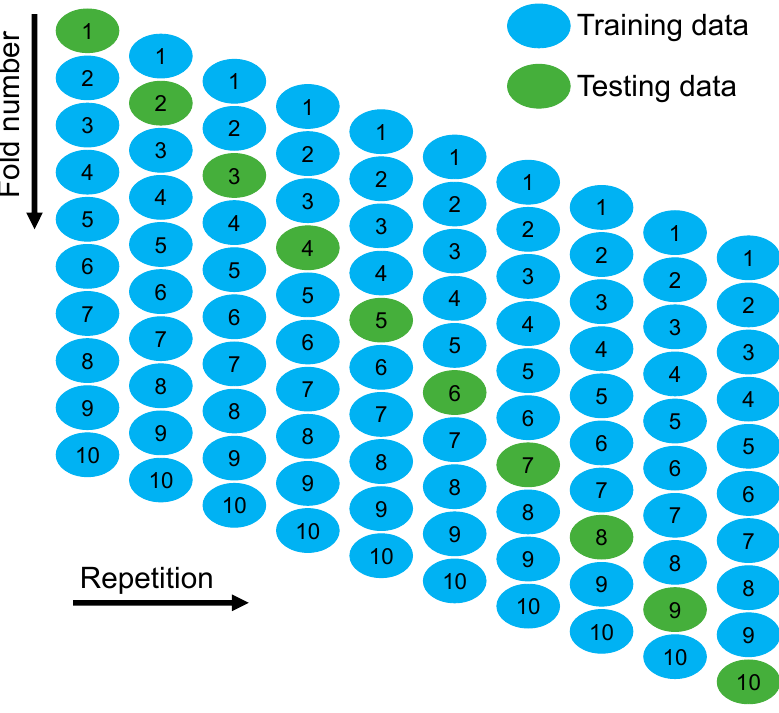
Figure 5. Schematic image of the k-fold approach [63] .